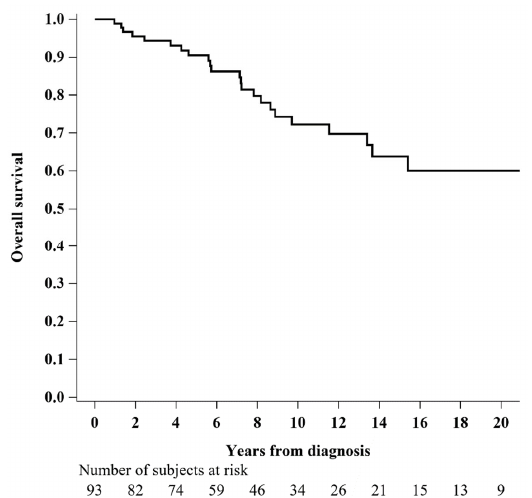
Figure 1. Overall survival of women affected by vulvar EMPD (N = 93).